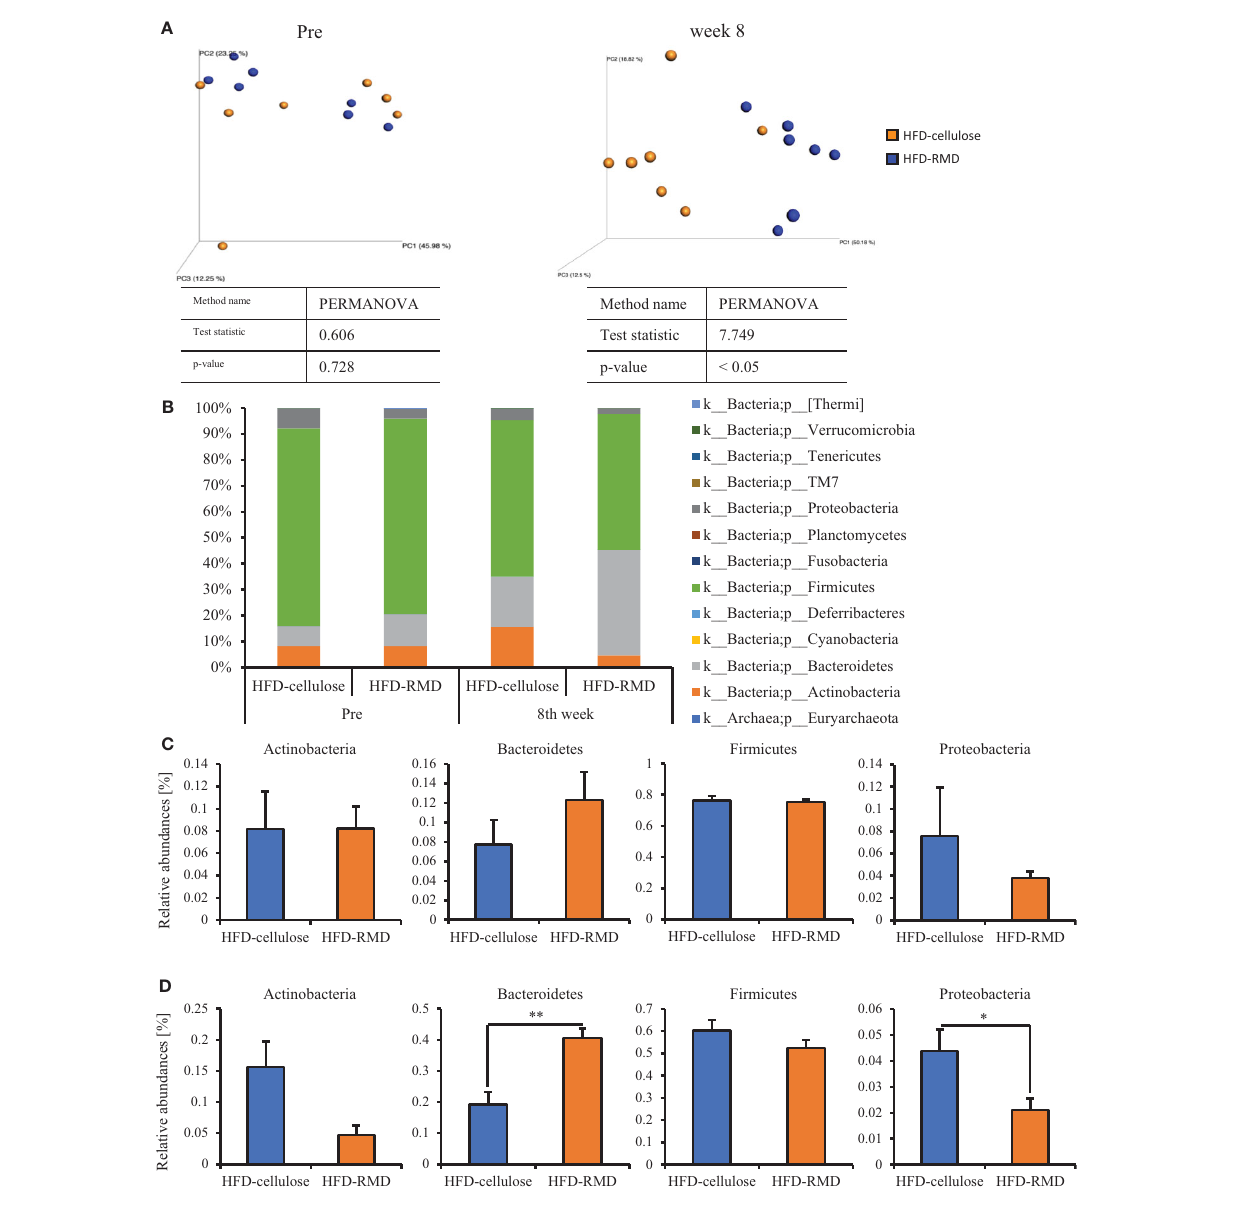
FIGURE 4 Effects of HFD-R on gut microbiota and relative abundance of some bacteria. (A) UniFrac principal coordinate analysis (PCoA) weighted intestinal microbiota. (B) Composition the intestinal microbiota. Relative abundance at phylum level (C) before and (D) after mice were fed with each diet for 8 weeks. All data are shown as means ± SEM (n = 7). * p < 0.05, ** p < 0.01 (unpaired t-test). genus level ( Bacteroides , Parabacteroides , and Dorea ) in mice maintained under each diet for 8